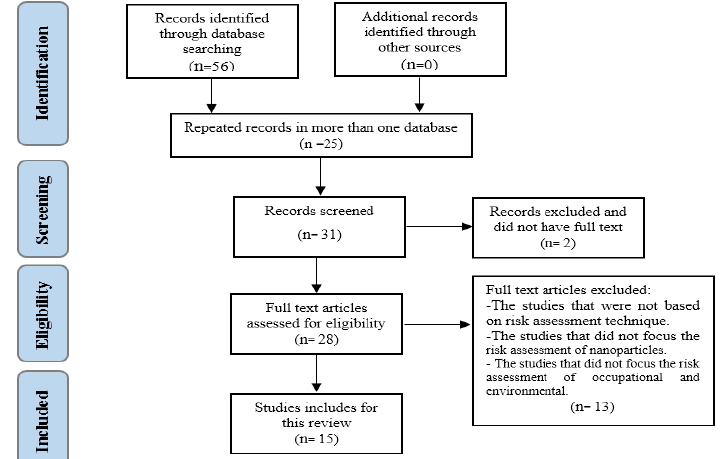
Fig. 1. Flow chart of the study identification and selection